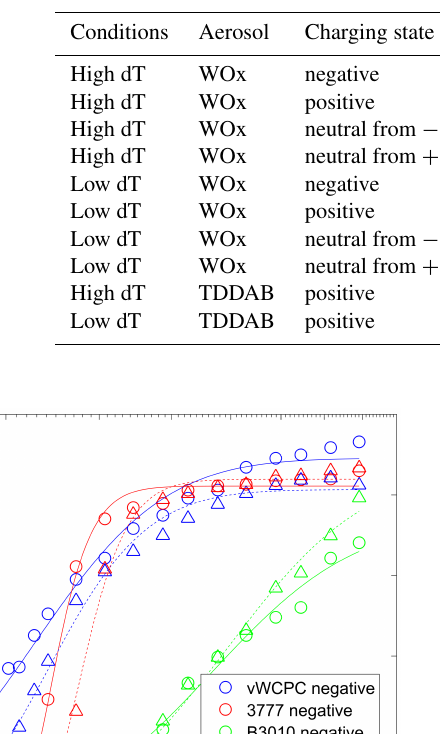
Table 2. All measured d50s (nm).